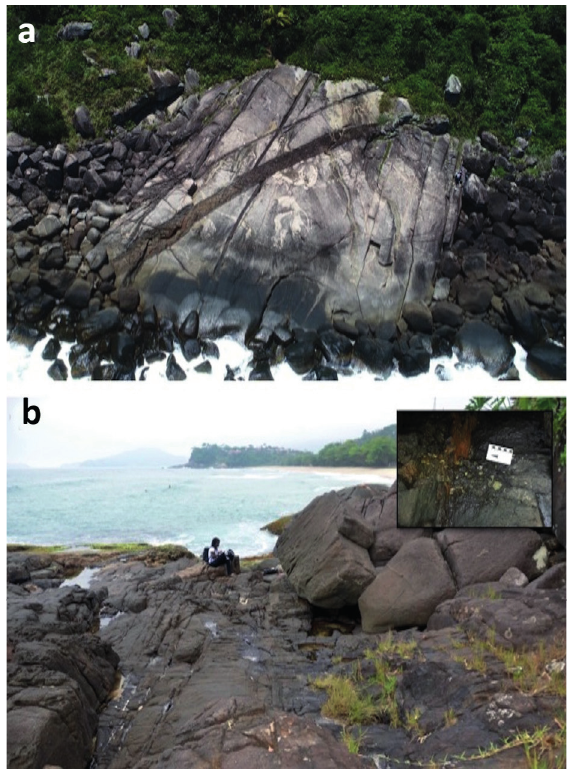
Figure 3 - representative geosites related to the GF Jurassic- Cretaceous magmatism. a ) Geosite “Dykes of Ilhabela”. An excellent example of the Jurassic-Cretaceous volcanic events associated to the fi rst stages of Gondwana breakup. Granitic gneisses from the basement are crosscut by both lamprophyre and basic dykes that show important chronological information related to the stress fi eld associated to the opening of the south Atlantic Ocean; b ) Geosite “Mantle xenoliths of Vermelha do Centro Beach”. Lamprophyre dyke with mantle xenoliths formed about 100 km deep. Features interpreted as explosive cones related to lamprophyre magmas also